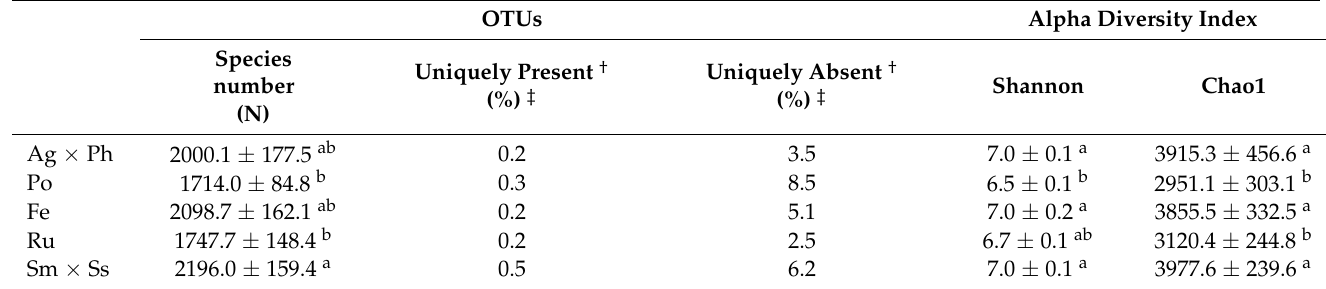
Table 3. OTU numbers and alpha diversity of soil bacterial community.